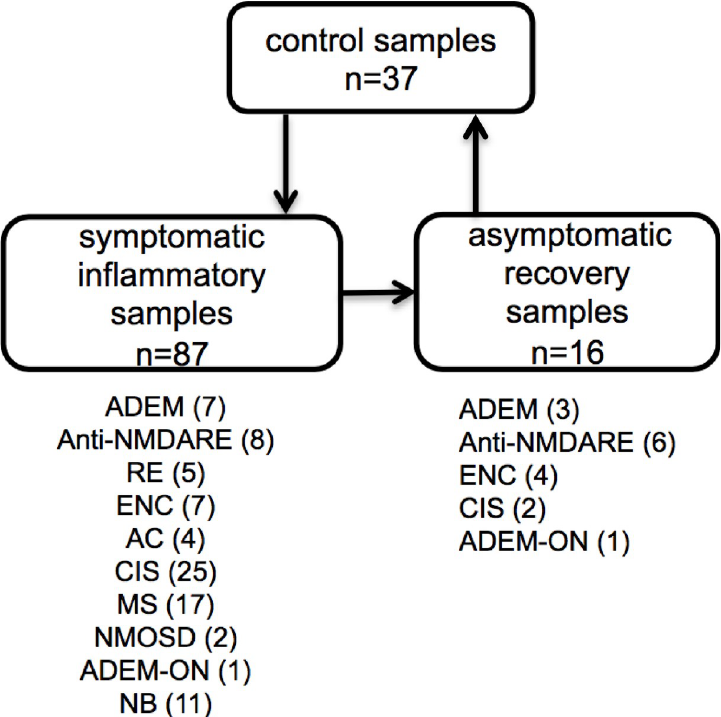
Fig 1. Study group description and design. CSF and serum samples from patients with various, mostly noninfectious, inflammatory CNS disorders collected at the time of presentation of clinical symptoms (n = 87) were compared with controls (n = 37). If available, follow-up samples collected at the time of clinical recovery (n = 16) were compared with their symptomatic counterparts and